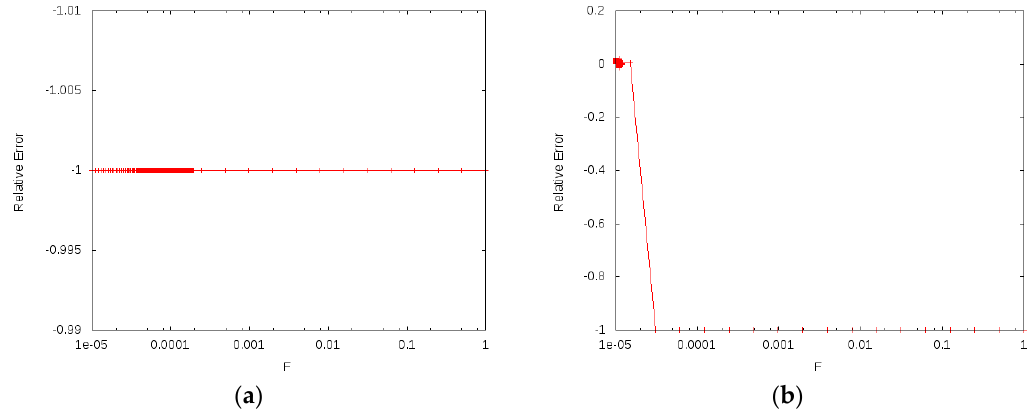
Figure 3. Dynamical behavior of MCMC-Flat 1/t and MCMC-Flat 1/t-pv on the same test problem: ( a ) MCMC-Flat 1/t does not converge when F is small enough; ( b ) MCMC-Flat 1/t-pv converges when F is small enough. Algorithm 2. Pseudo Visit (PV) of Histogram